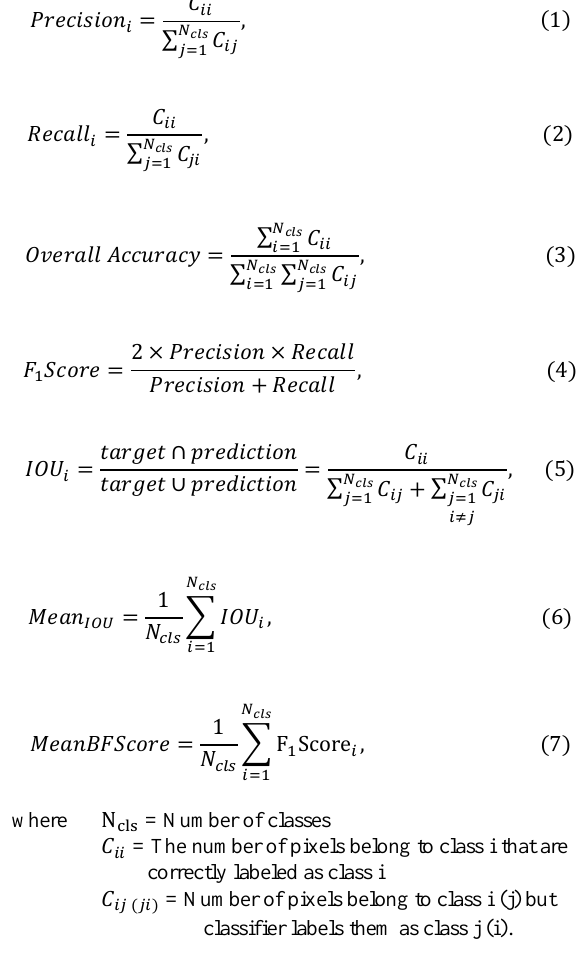
Figure 5 . Multi-Layer perceptron architecture.